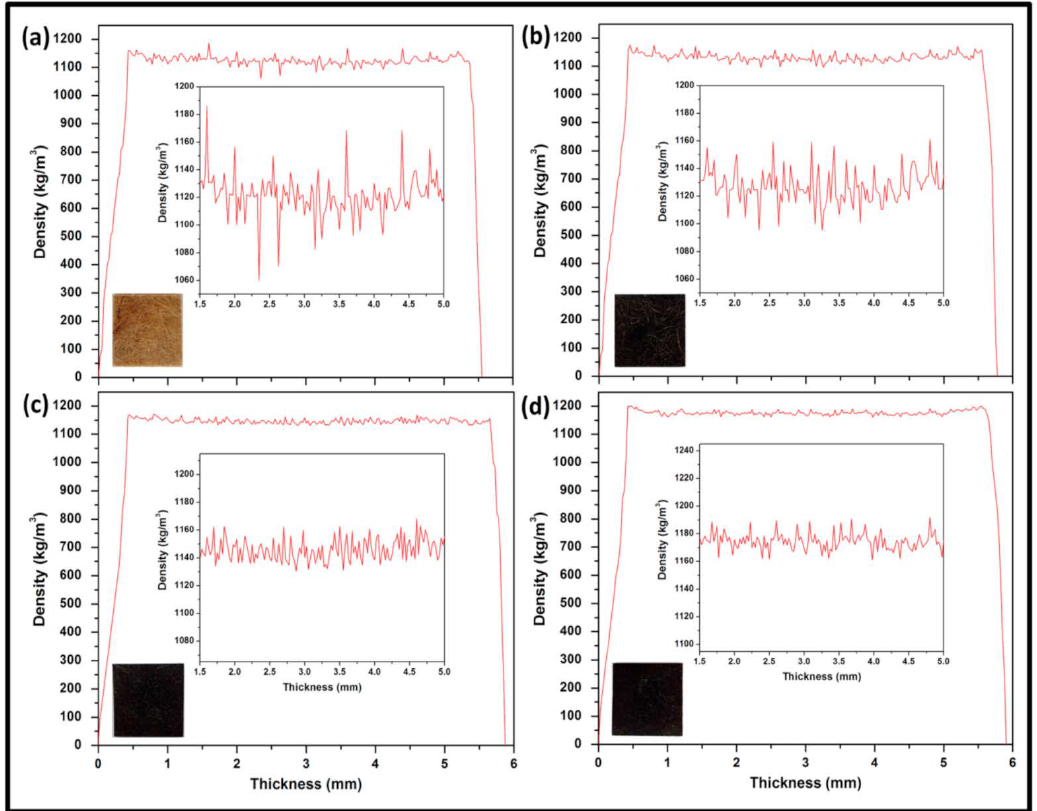
Figure 4. X-ray Density Profile of ( a ) VE/K/NC0 ( b ) VE/K/NC1( c ) VE/K/NC3 and ( d )